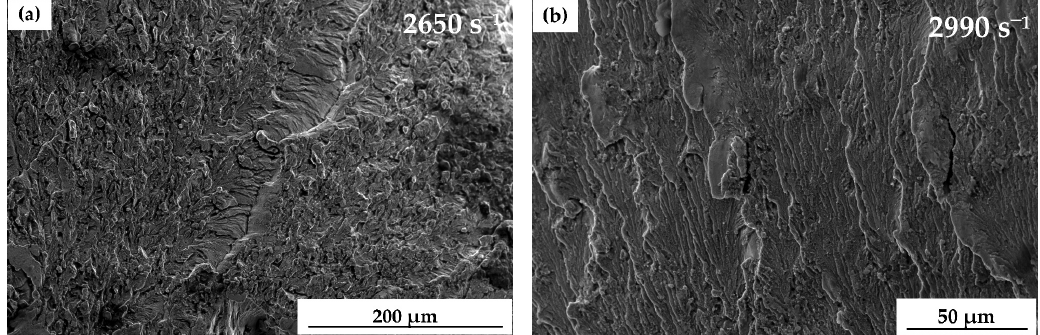
Figure 7. Rough region in the fracture surface of dynamic compressive tests: ( a ) 2650 and ( b ) 2990 s − 1 .